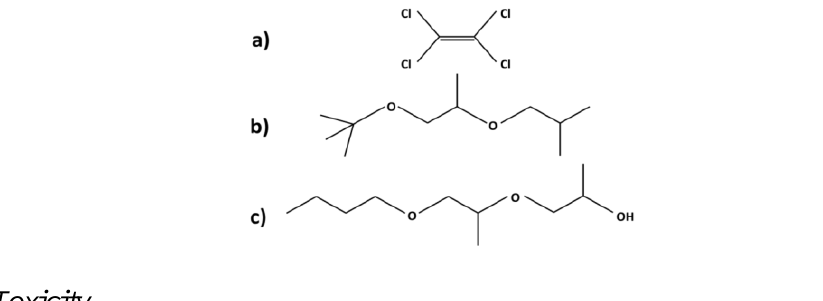
Figure 2. Three chemicals under consideration in this study: ( a ) perchloroethylene (PCE) [19]; ( b ) dipropylene glycol tertiary -butyl ether (DPtB) [10]; and ( c ) dipropylene glycol n -butyl ether (DPnB)